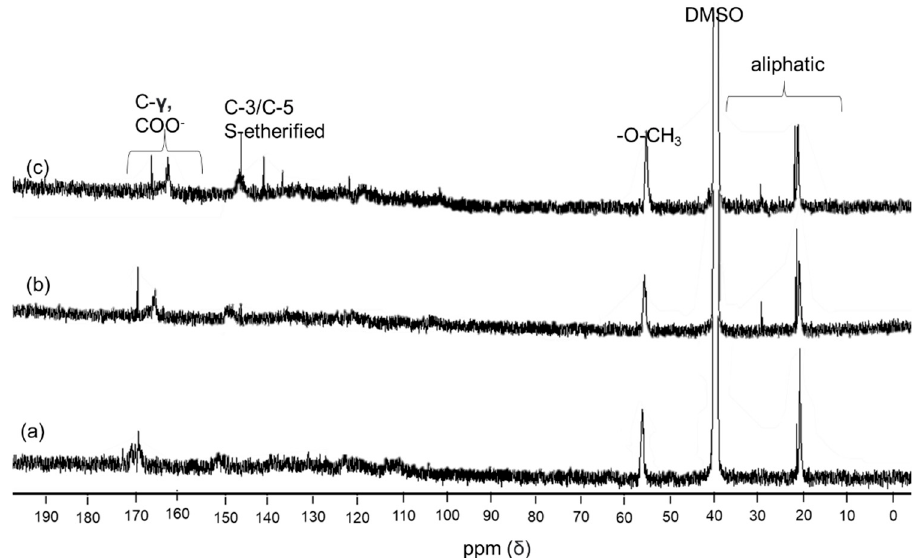
Figure 5. 13 C NMR spectra of standard lignin ( a ), single-step lignin ( b ), and fractionated-step lignin ( c